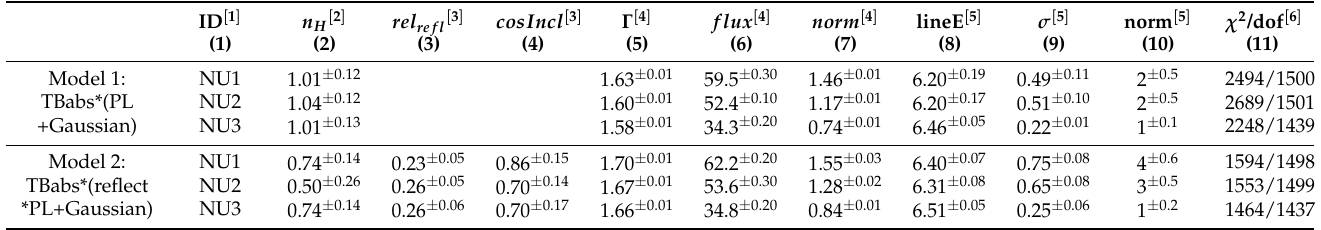
Table 3. Fitted parameters for NuSTAR data with PL/ REFLECT *PL model along with a Gaussian